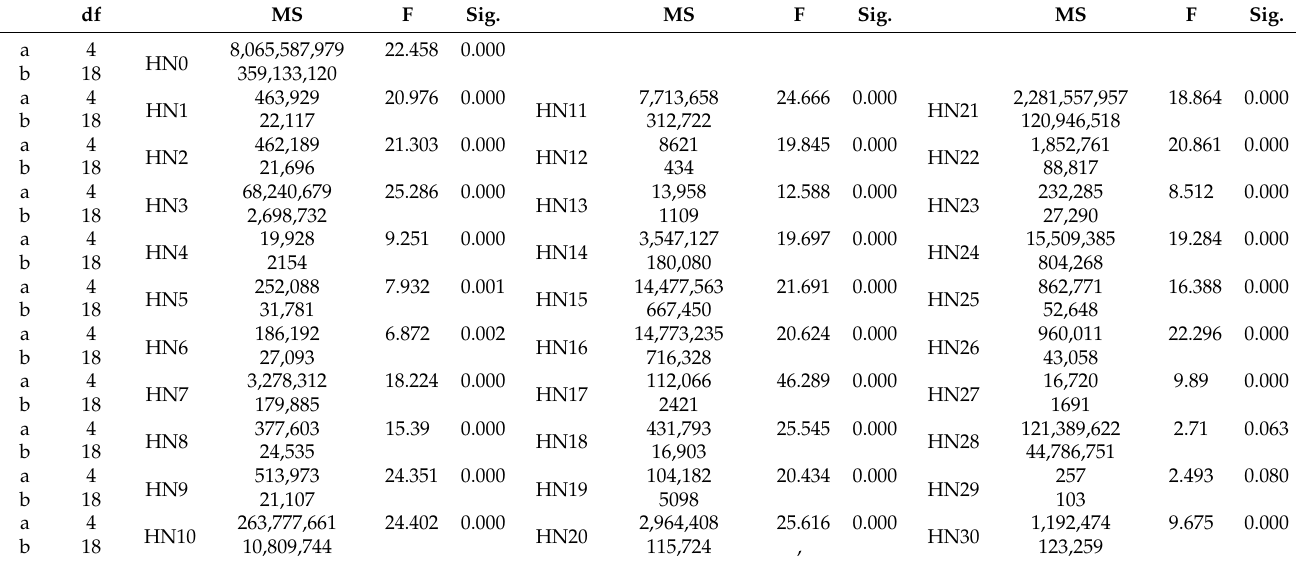
Table 9. ANOVA (Household Number).